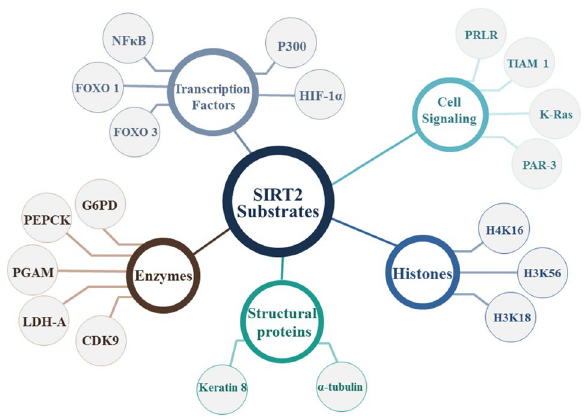
Figure 1. Illustrative diagram for SIRT2 substrates.